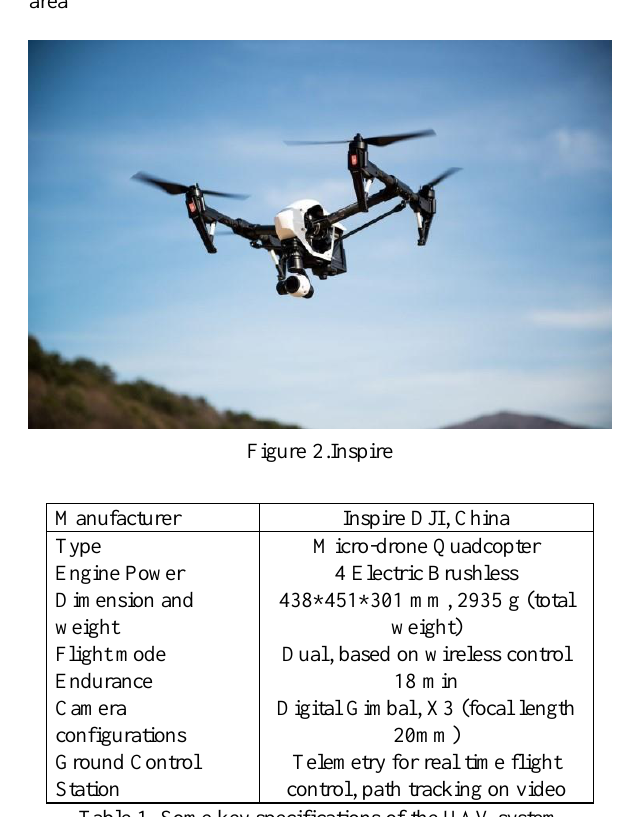
Figure 1. Location of study area (Songjung beach)